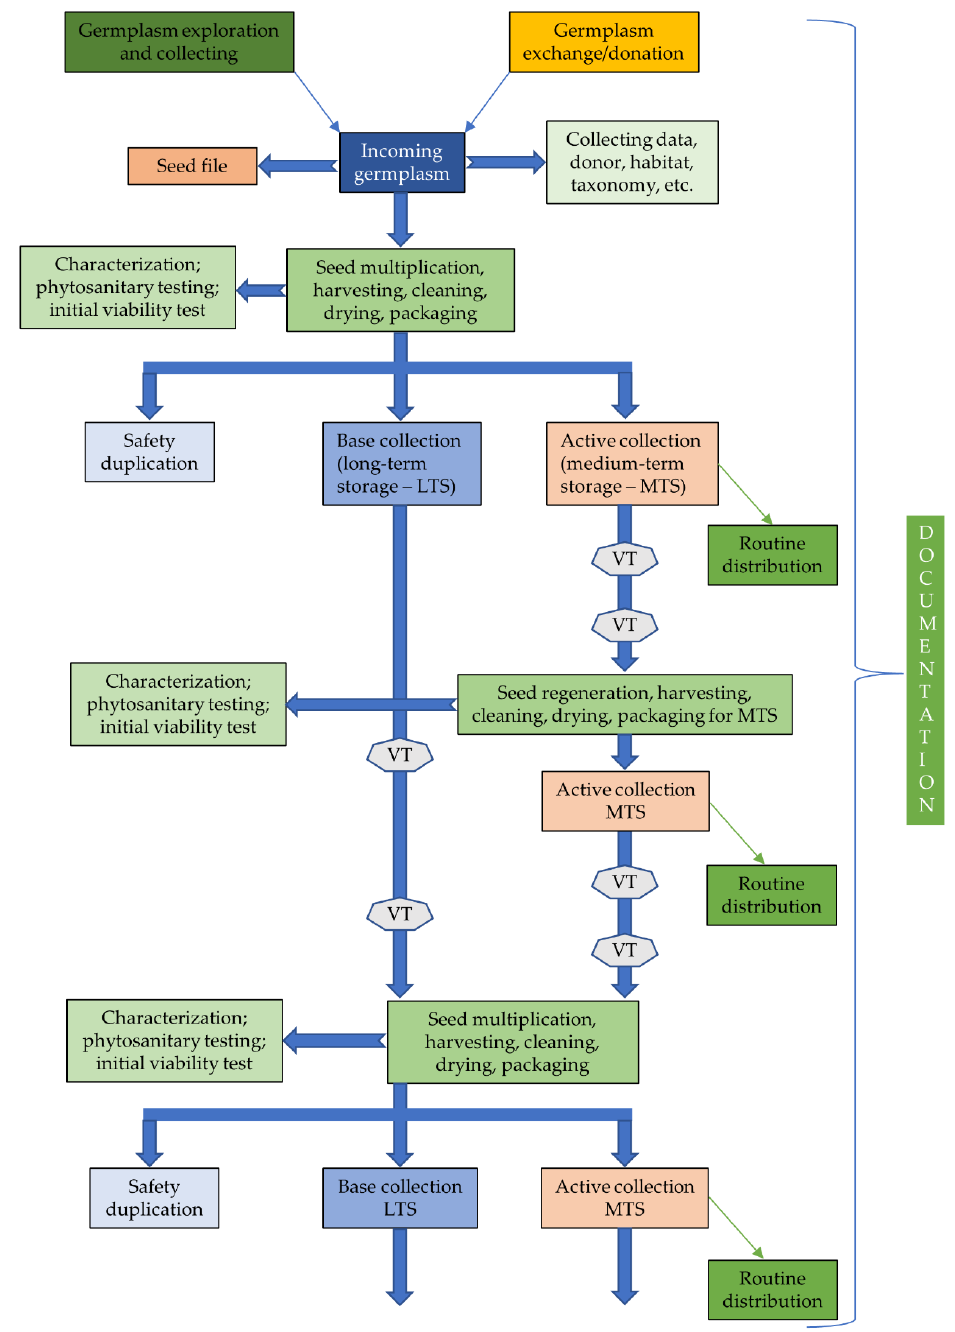
Figure 1. Overview of standard operations in a seed gene bank, based on the FAO Genebank Standards [5] and adapted from Hay and Sershen [6]. Germplasm arriving at a gene bank through a collecting mission or exchange/donation from